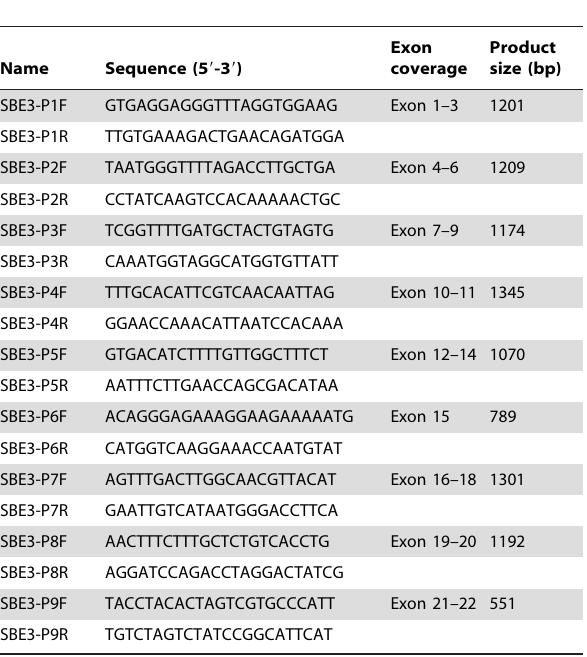
Table 3. Primers used for sequencing the putative gene SBE3 (LOC_Os02g32660).